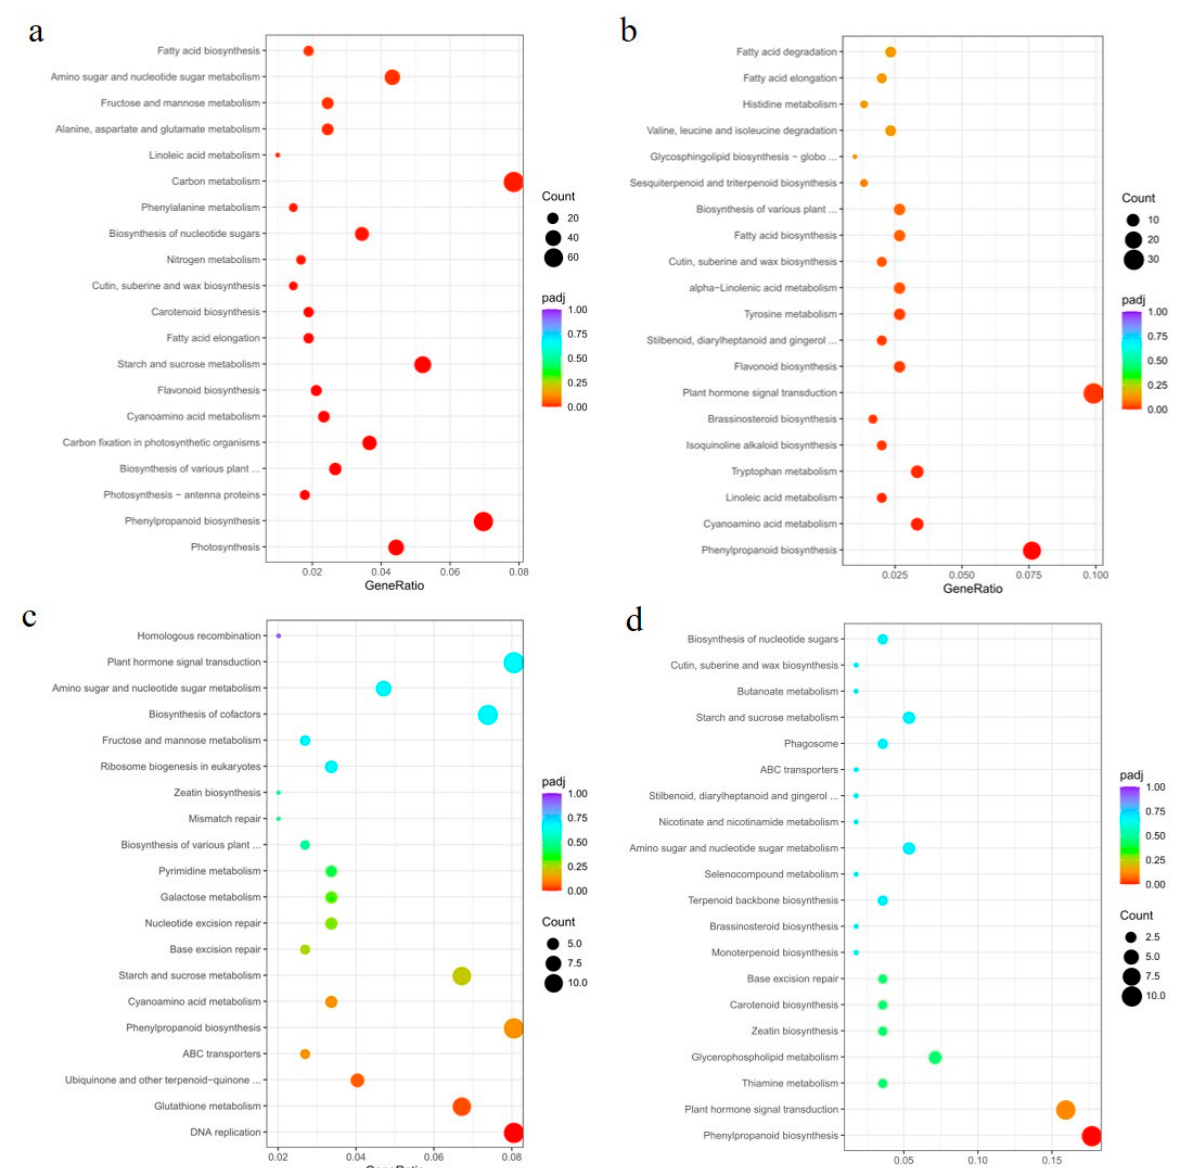
Figure 6. KEGG pathway enrichment analysis of DEGs between the OE and KO lines. ( a ) KEGG pathway analysis of DEGs identified between OE49 and WT leaves. ( b ) KEGG pathway analysis of DEGs identified between OE8 and WT leaves. ( c ) KEGG pathway analysis of DEGs identified in the roots of KO1 and KO5 compared with the WT. ( d ) KEGG pathway analysis of DEGs identified in the roots of KO1, KO5, OE49, and OE8 compared with the WT.